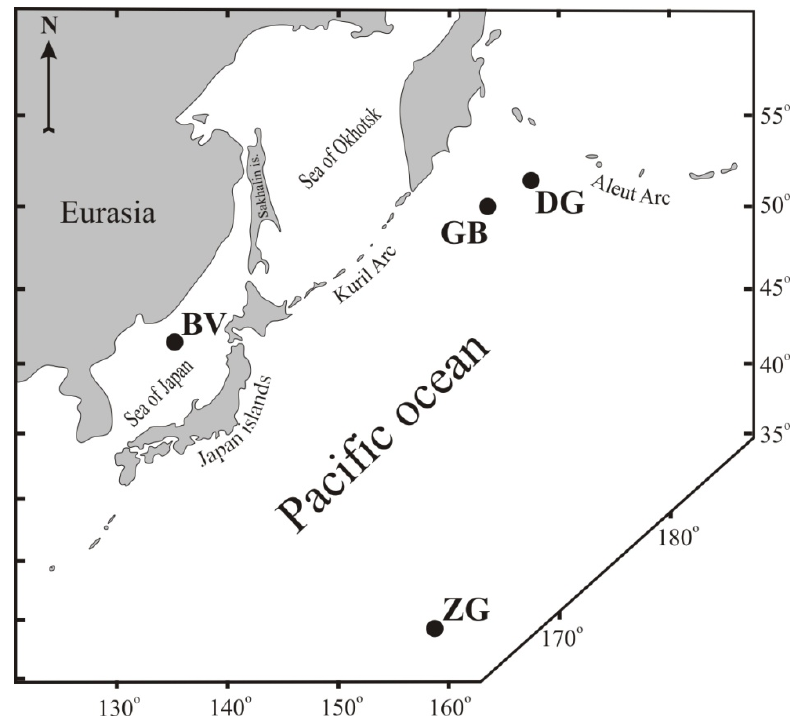
Figure 1. Scheme of the location of ferromanganese deposits. DG: Detroit guyot (D13), ZG: Zubov guyot (33D17-1), GB: Gummi Bear seamount (DR92-11), BV: Belyaevsky underwater volcano (2069). Table 1. Coordinates of sampling of ferromanganese crusts and geological setting of their